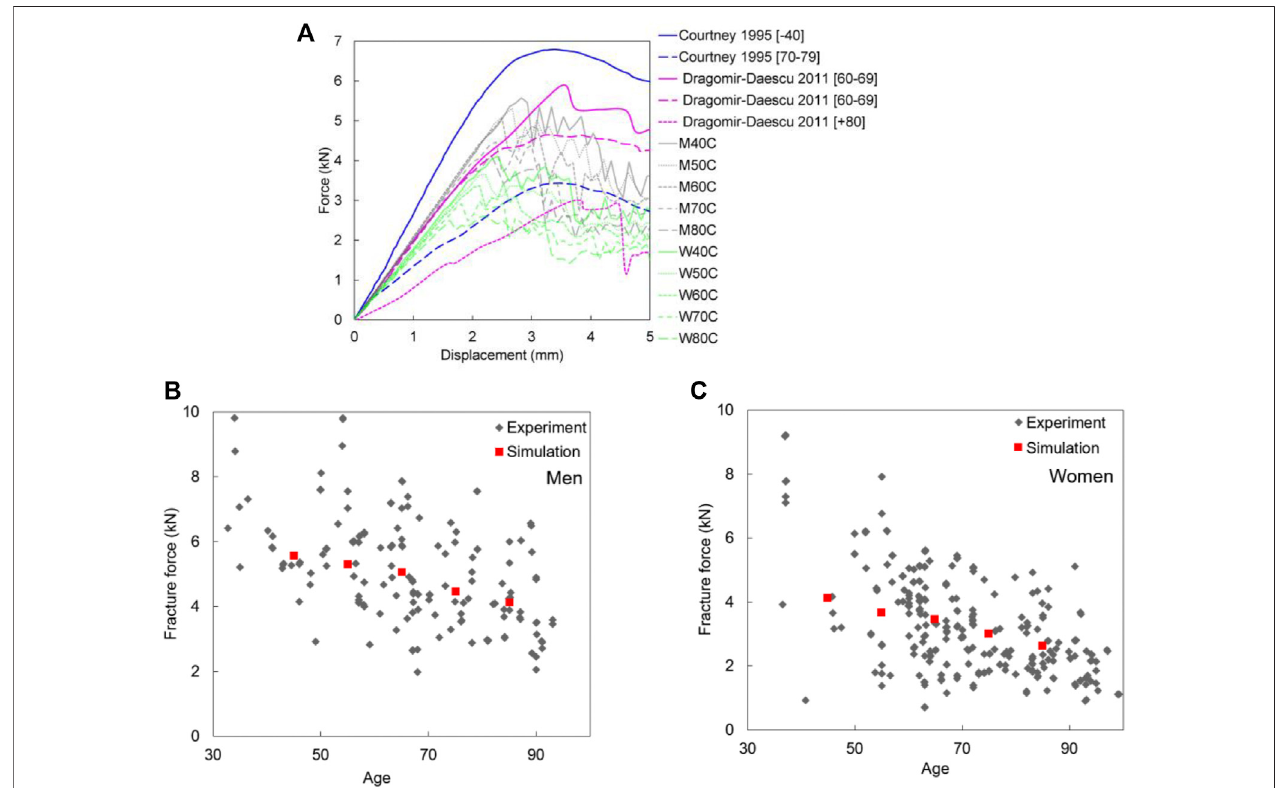
FIGURE 6 | (A) Comparison of experimental force-displacement curves of a similar test setup with simulation results of MechGeomAge set (Courtney et al., 1995; Dragomir-Daescu et al., 2011); Pooled maximum fracture forces data (grey) (de Bakker et al., 2009; Op Den Buijs and Dragomir-Daescu 2011; Rezaei and Dragomir- Daescu 2015; Kroker et al., 2017; Rezaei et al., 2017; Dragomir-Daescu et al., 2018; Patton et al., 2019) for (B) men and (C) women compared tothe simulation results (red) for the combined changes (MechGeomAge